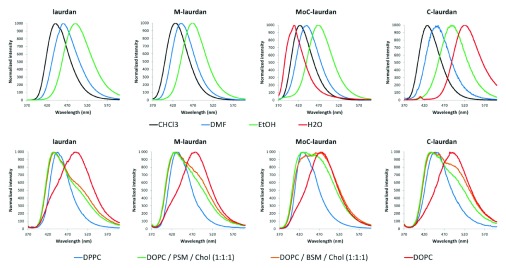
Normalized emission spectra of dyes in solvents and lipid vesicles for So, Lo and Ld phases.Upper panels show normalized emission spectra of laurdan, M-laurdan, MoC-laurdan and C-laurdan in chloroform, Dimethylformamide, ethanol and water (when detectable, i.e. only for Moc-laurdan and C-laurdan). The blue shift seen for the emission spectrum for MoC-laurdan in water is attributed to the fluorescence of non hydrated aggregates, whereas C-laurdan which is highly soluble in water undergoes the expected red shift.Lower panels show emission spectra of laurdan, M-laurdan, MoC-laurdan and C-laurdan in LUVs made of DPPC (So, blue), DOPC/PSM/chol 1:1:1 (Lo, green), DOPC/BSM/chol 1:1:1 (Lo, orange) and DOPC (Ld, red) at 25°C.